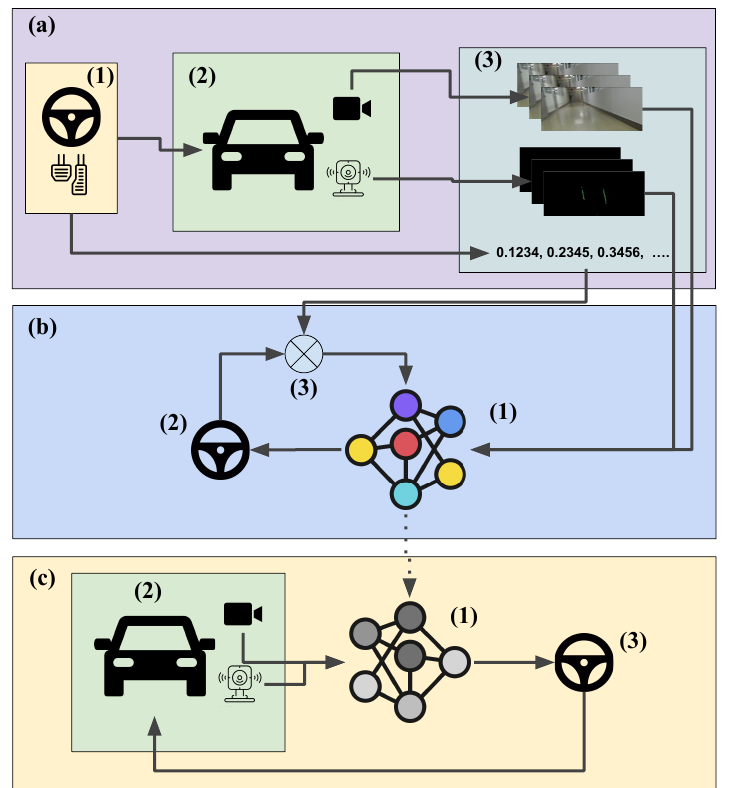
Figure 17. The high-level system architecture of end-to-end behavioral cloning. ( a ) Data acquisition system: ( a-1 ) human driver. ( a-2 ) vehicle platform. ( a-3 ) collected data (images, LIDAR data, steering, and throttle). ( b ) Neural network training: ( b-1 ) input data. ( b-2 ) steering angle prediction. ( b-3 ) errors are fed to the neural network. ( c ) Testing the trained neural network: ( c-1 ) trained neural network deployed. ( c-2 ) vehicle platform. ( c-3 ) steering angle predictions from the neural network